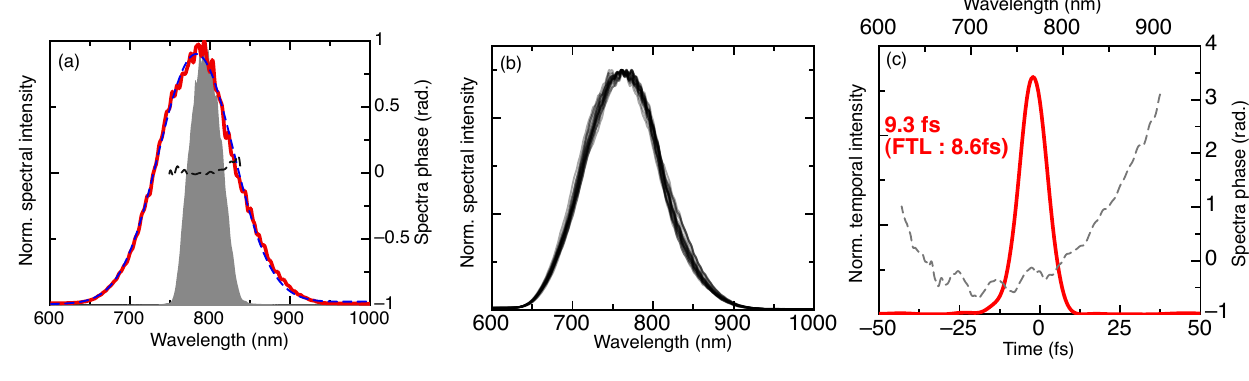
Figure 2. ( a ) Initial fundamental spectral amplitude (shaded area) and phase (dashed black line), measured after the TGC. XPW spectrum (red line) with a Gaussian fit (dashed blue line, 105 nm FWHM); ( b ) Density plot of XPW spectra (averaged over 500 shots) recorded every 5 nm over 90 nm. Lower spread corresponds to higher stability; ( c ) Temporal intensity profile and residual spectral phase of the compressed XPW pulse measured by